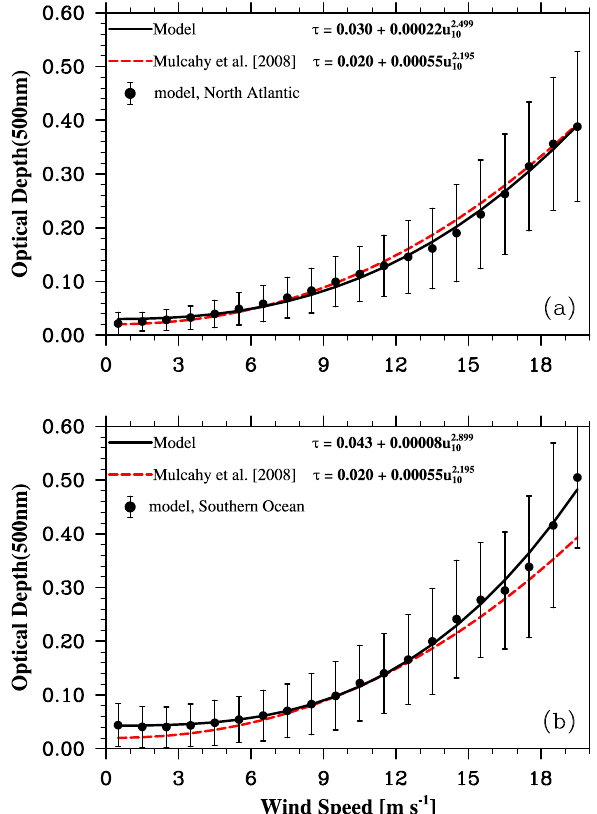
Fig. 9. Wind speed dependence of sea-salt optical depth in (a) North Atlantic and (b) roaring forties (60 ◦ S–40 ◦ S) in 1994. Dots are the modeled yearly-averaged optical depths displayed in the middle of the wind speed interval. Error bars represent one standard deviation of the values in the region. The dashed lines are the optical depths of the power-law relationship of Mulcahy et al. (2008) using model 10m wind speed with constant term scaled down to 0.02.The model used the CMS source function and a solubility factor of